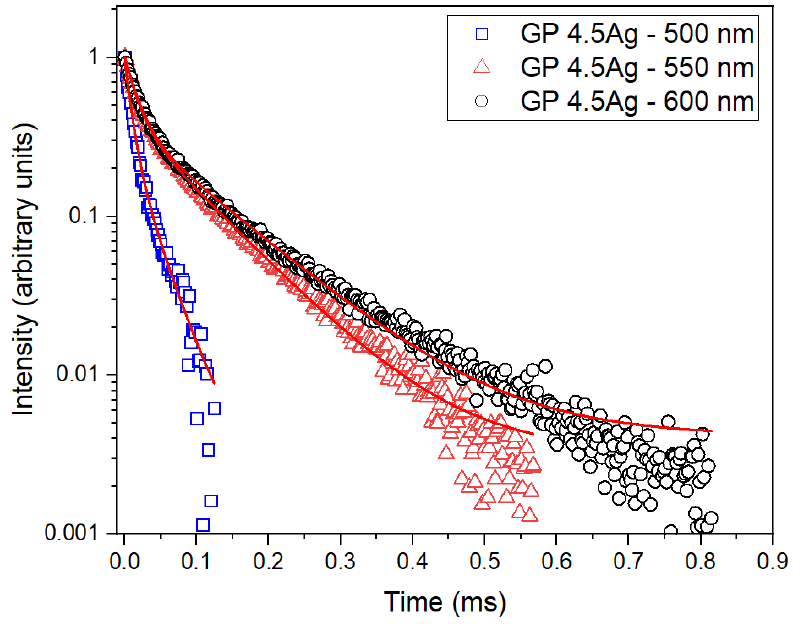
Figure 6. Ag NCs PL decay curves with detection at 500, 550, and 600 nm, under 405 nm excitation for the GP 4.5 Ag sample. Table 1 . PL decay lifetimes (fast and slow components) of Ag NCs: GP 4.5Ag sample under 405 nm excitation, and detection at 500, 550, and 600 nm.